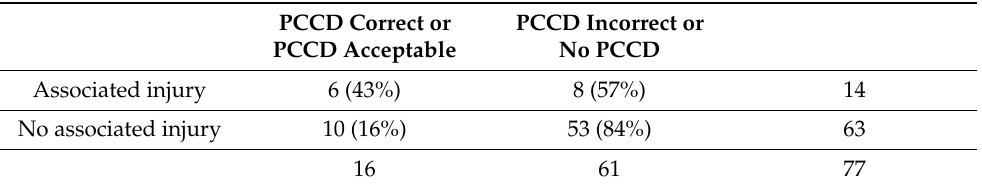
Table 7. Contingency table of all documented associated injuries in relation to the position of the applied